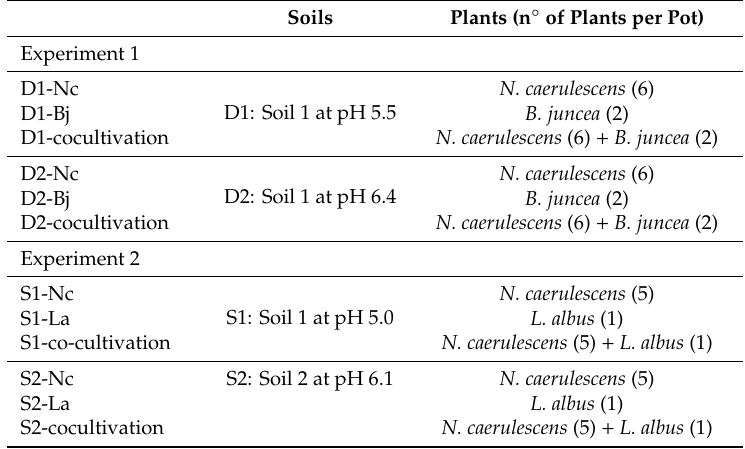
Table 2. The di ff erent soil / plant combinations used in the